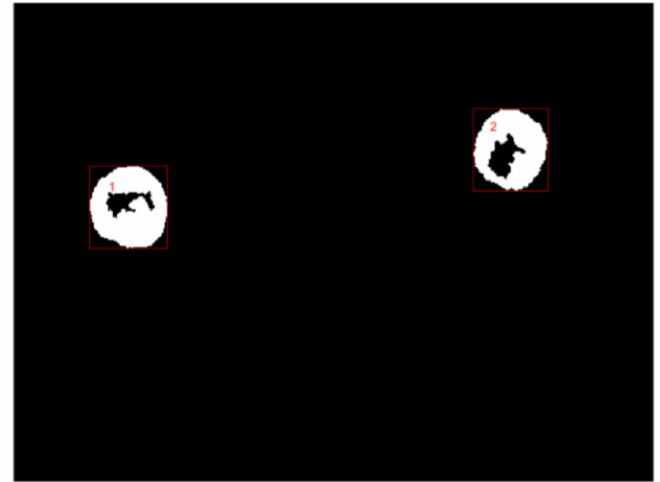
Figure 9. Cell identification and